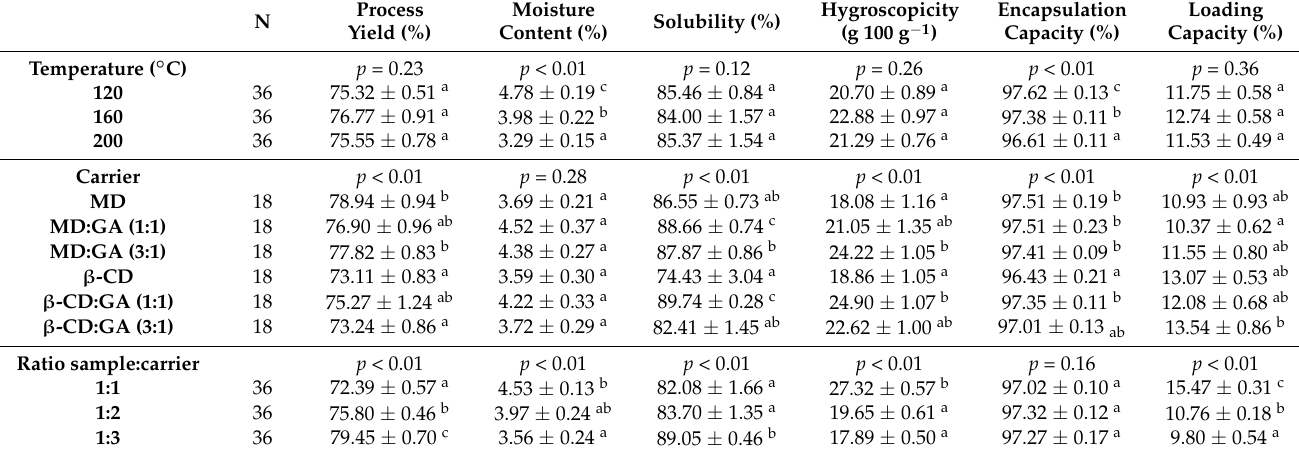
Results are expressed as mean ± SD (N = 4). Values with different letters within column are statistically different at p <